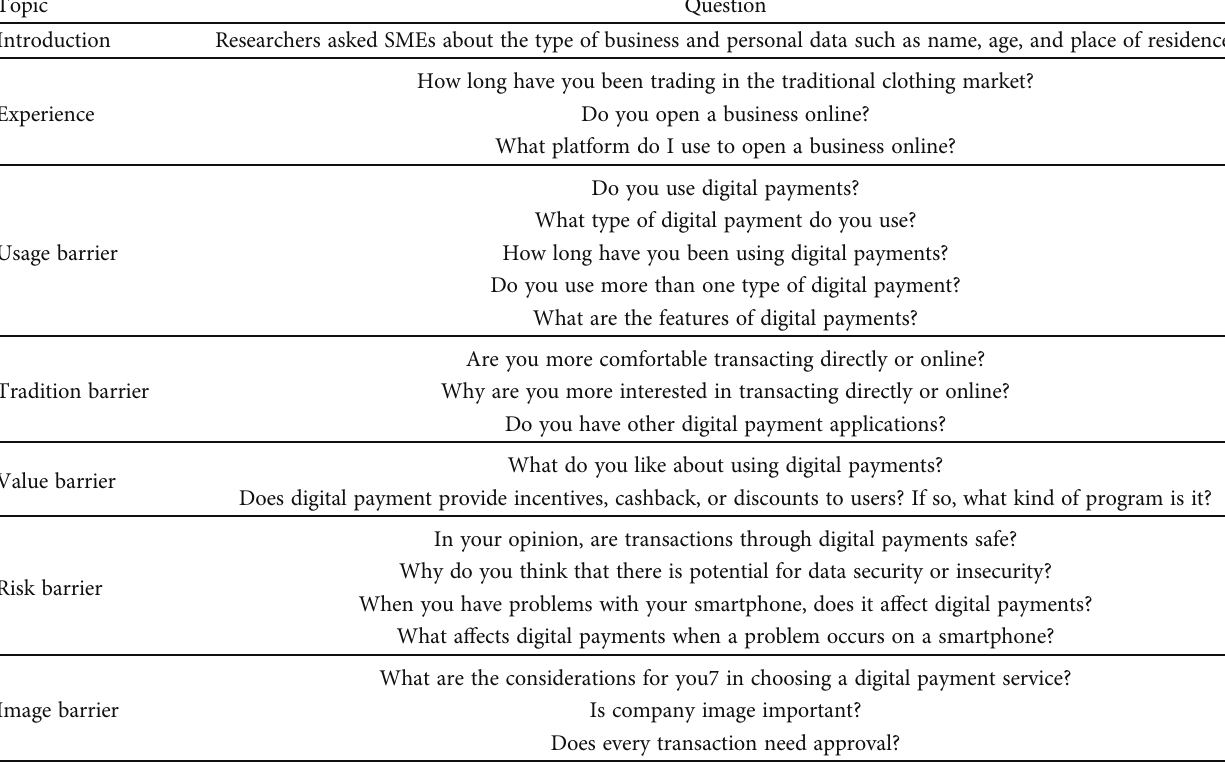
Table 1: Research questions.